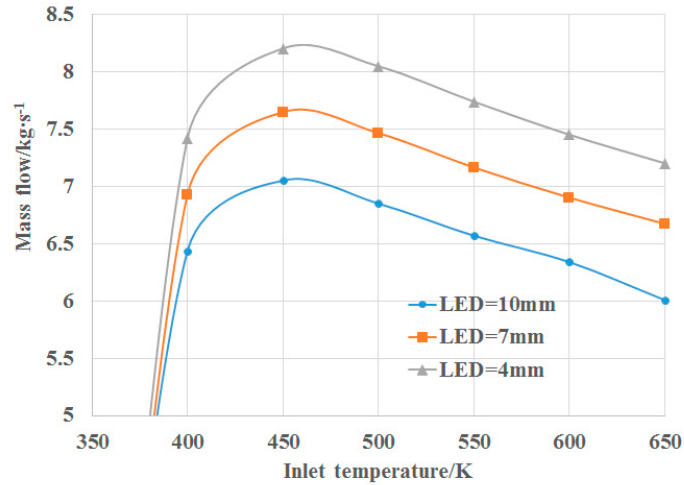
Figure 14. Correlation of inlet temperature towards mass flow.